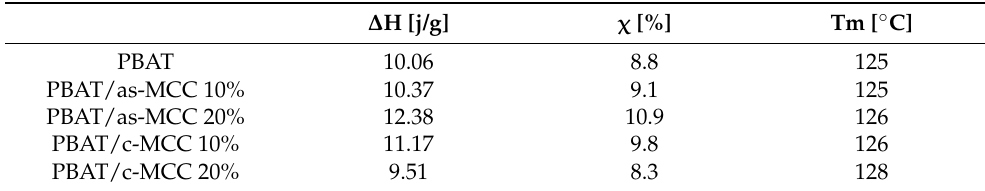
Figure 9. Differential scanning calorimetry (DSC) thermograms recorded during the first heating scan of ( A ) PBAT/as-MCC and ( B ) PBAT/c-MCC biocomposites; Differential scanning calorimetry (DSC) thermograms recorded during the second heating scan of ( C ) PBAT/as-MCC and ( D ) PBAT/c- MCC biocomposites. Table 2. Thermal properties collected during the second heating scan for all investigated systems.